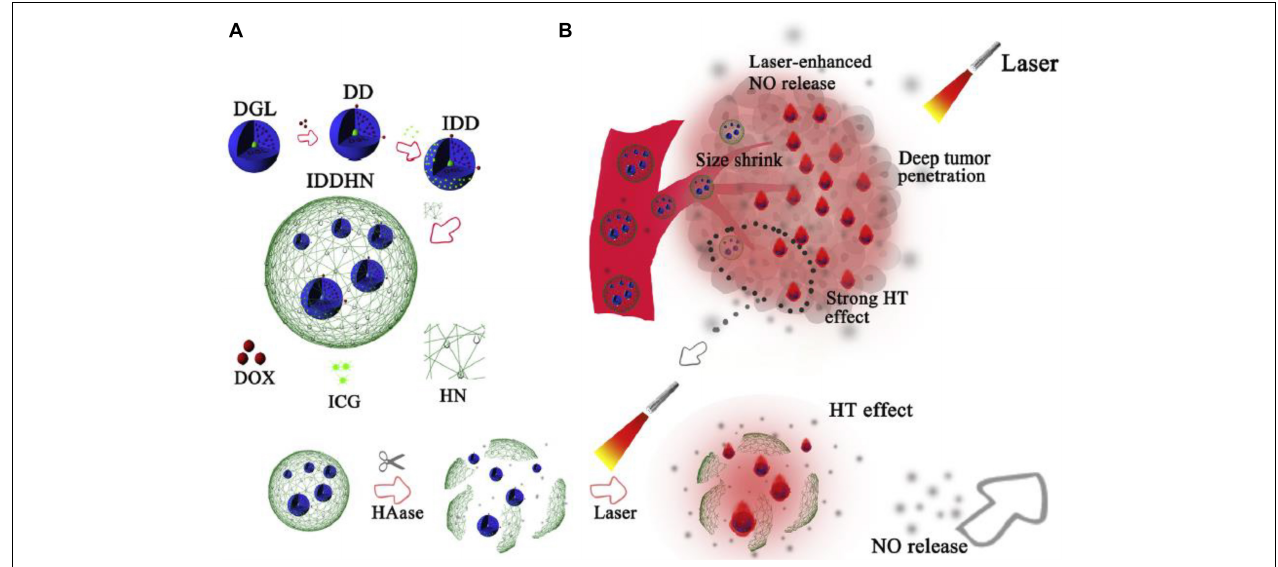
FIGURE 5 | (A) Schematic design of hyaluronidase-triggered size-shrinkable HA shells, which were modified with NIR laser-sensitive NO donor (HN), small-sized dendrimeric prodrug (IDD) of DOX as chemotherapy agent and indocyanine green (ICG) as photothermal agent into a single nanoparticle. (B) Synergistic effects for deep tumor penetration and therapy effects were realized via rupture of HA shells triggered by hyaluronidase and improved EPR effect by laser-enhanced NO release upon strong hyperthermia effect of indocyanine green (reproduced with permission from Hu et al. (2018b). Copyright 2018 Elsevier).